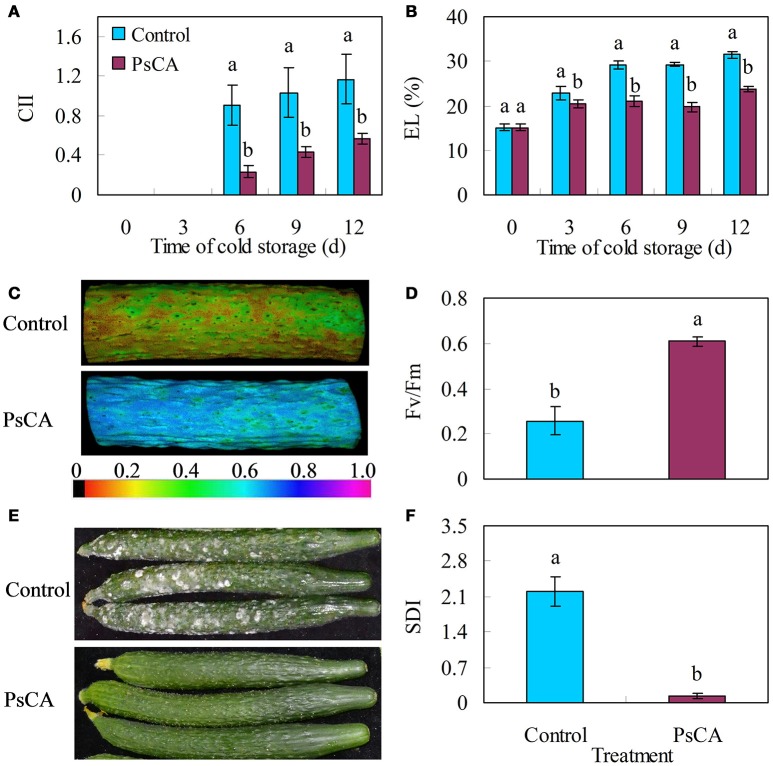
Chilling severity of harvested cucumber. (A) chilling injury indices (CII); (B) electrolyte leakage (EL); (C,D) images and values of the maximum PSII quantum yield (Fv/Fm), evaluated after 12 d storage at 5°C. The color code depicted at the bottom of the image ranged from 0 (left) to 1.0 (right); (E,F) secondary disease pictures were taken and severity evaluated on the 4th d after the cucumbers were transferred to ambient temperature (20°C) following 12 d of storage at 5°C. Control fruit were directly placed at 5°C. Pre-storage cold acclimation (PsCA) treated fruit were first incubated at 10°C for 3 d and then stored at 5°C. Significance of differences between the control and PsCA are indicated by letters above the bars (P ≤ 0.05). Data are presented as means ± standard errors (n = 3).